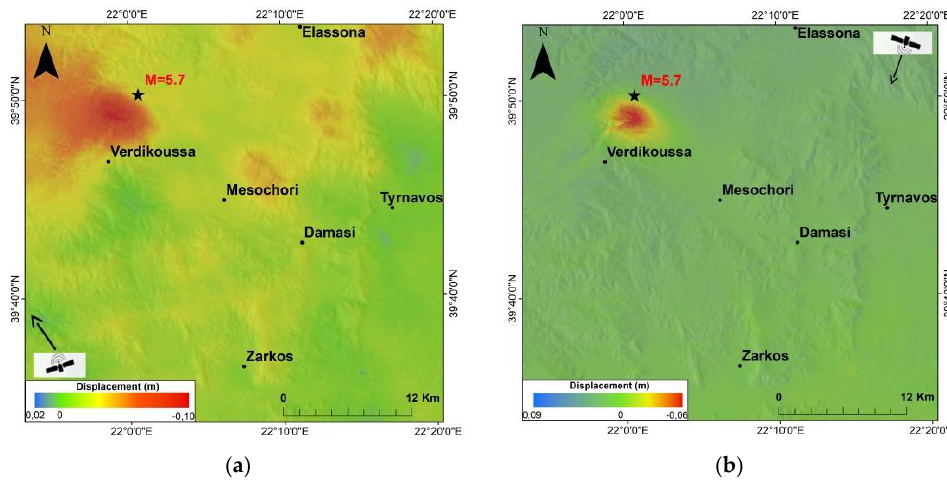
Figure 18. Earthquake of 12 March 2021: ( a ) LoS displacement in ascending mode (9 March 2021 master and 15 March 2021 slave image), ( b ) LoS displacement in descending mode (8 March 2021 master and 14 March 2021 slave image); star illustrates the relocated epicenter.